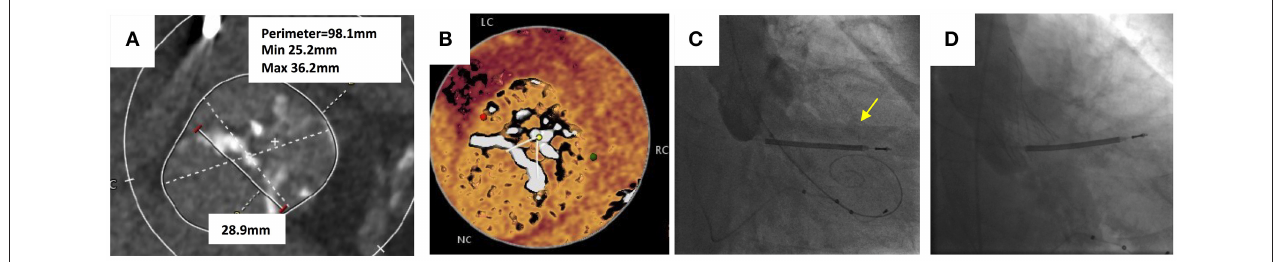
FIGURE 8 | Transcatheter aortic valve replacement in bicuspid aortic valve. (A) Sievers Type 1 bicuspid valve with partial raphe between the right and left cusps. Large annulus with perimeter measuring 98.1mm and an intercommisural distance of 28.9mm. (B) “Hockey puck” view of the bicuspid valve shows partial raphe between left and cusps. (C) Balloon valvuloplasty with 25mm balloon for sizing prior to TAVI implantation. Yellow arrow shows leak of contrast into left ventricle during simultaneous aortogram indicating inadequate seal. (D) 34mm Evolute R deployed at leaflet tips with no paravalvular leak.